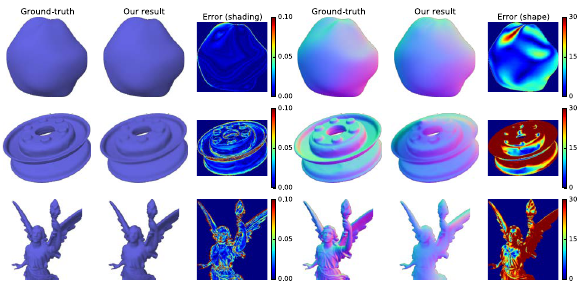
Fig. 19 Shape analysis results for Lambertian reflectance. Blob (top): small errors in shape and shading. Pulley (middle): large errors in shape. Lucy (bottom): large errors in